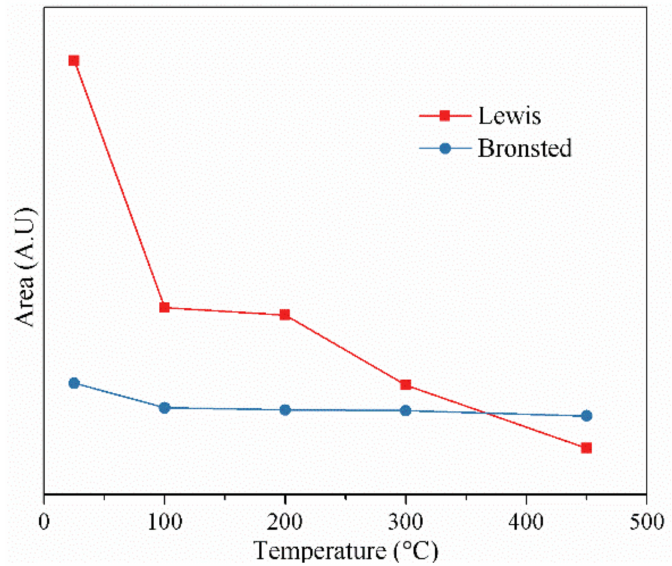
Figure 7. Normalized area of NH 3 adsorbed on Lewis and Brønsted acid sites of the catalyst as a function of temperature.